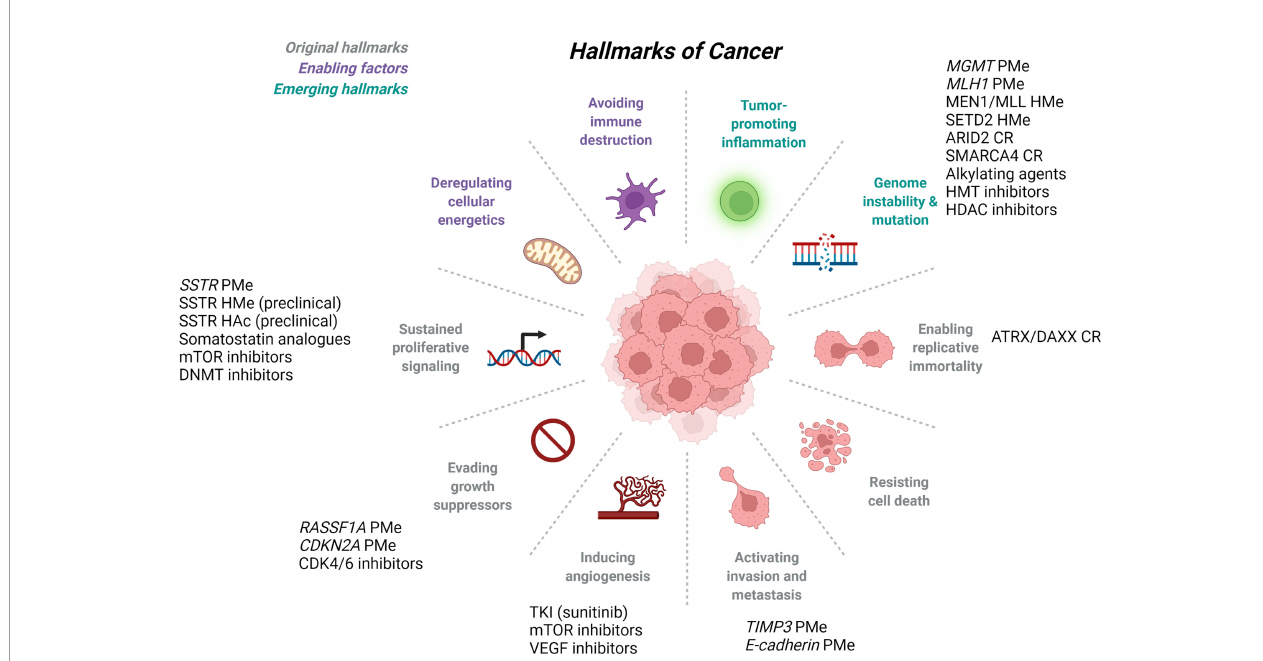
FIGURE 1 | Hallmarks of Cancer and Epigenetic Regulation of GEP-NETs . The original Hallmarks of Cancer as published in 2000 by Hanahan and Weinberg (gray), were updated in 2011 to include additional enabling factors (purple) and emerging hallmarks of cancer (teal). GEP-NETs have been studied in several of the de fi ned hallmarks of cancer, and listed here are the epigenetic mechanisms and therapeutics associated with each. ARID2, AT-rich interactive domain 2; ATRX, alpha-thalassemia/mental retardation, X-linked; CDK4/6, cyclin dependent kinase 4/6; CDKN2A, cyclin dependent kinase inhibitor 2A gene; CR, chromatin remodeling; DAXX, death domain-associated protein; DNMT, DNA methyltransferase; HAc, histone acetylation; HDAC, histone deacetylase; HMe, histone methyltation; HMT, histone methyltransferase; MEN1, multiple endocrine neoplasia type 1; MGMT, O-6-methylguanine DNA methyltransferase gene; MLH1, mutL homolog 1; MLL, mixed lineage leukemia lysine methyltransferase 2A; mTOR, mammalian target of rapamycin; PMe, promoter methylation; RASSF1A, ras associated domain family 1 gene; SETD2, set domain-containing protein 2; SMARCA4, SWI/SNF-related matrix associated actin dependent regulator of chromatin subfamily a, member 4; SSTR, somatostatin receptor; TIMP3, tissue inhibitor of metalloproteinase 3 gene; TKI, tyrosine kinase inhibitor; VEGF, vascular epithelial growth factor. Adapted from “ Hallmarks of Cancer ” by BioRender.com (2022), Retrieved from https://app.biorender.com/biorender-